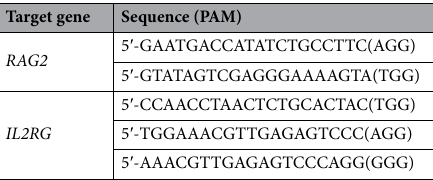
Table 1. Target sequences of RAG2 and IL2RG sgRNAs.